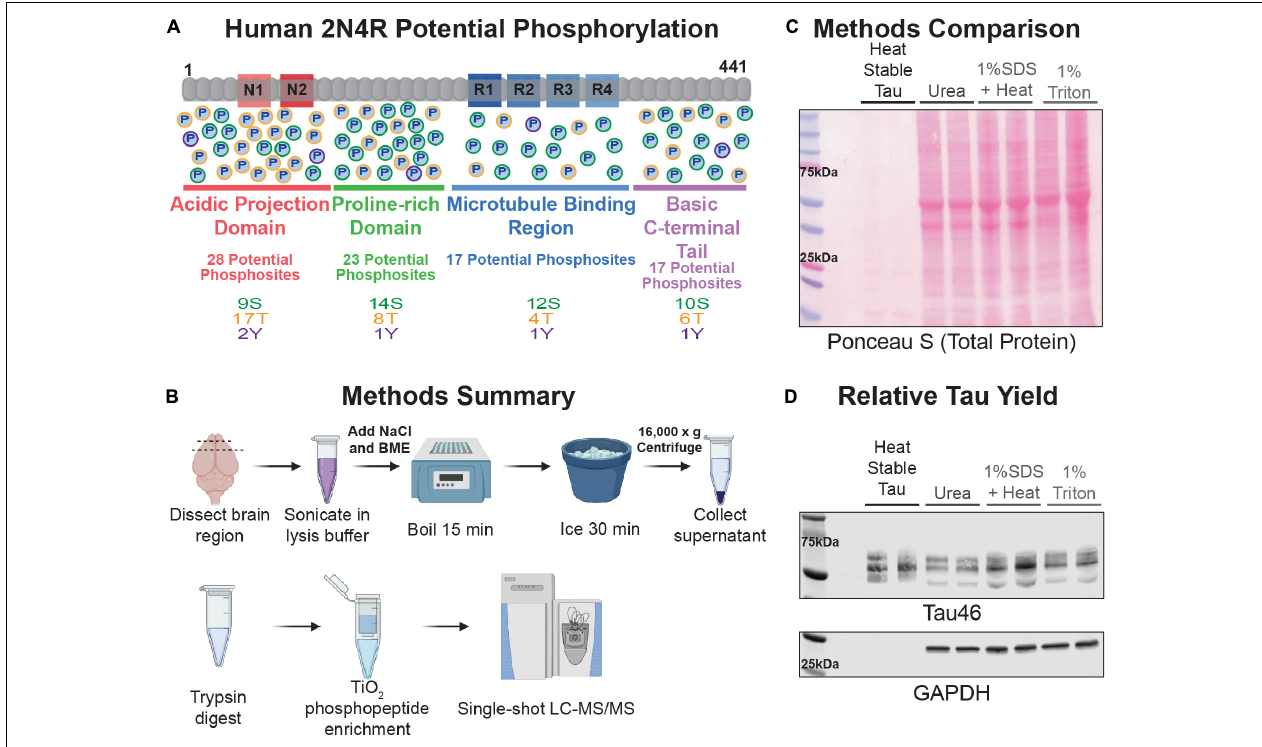
FIGURE 1 | Technique Overview. (A) Schematic representation of the longest isoform of human tau, 2N4R. The domains are represented and underlined with a length proportional to their amino acid number in the protein (acidic projection domain is red, proline-rich region is green, microtubule binding region is blue, and the basic C-terminal tail is lavender). Potential phosphorylation sites are represented by circles with a “P” in the middle in each domain and are color coded by residue type (serine outlined in green, threonine in orange, tyrosine in purple). (B) Cartoon summary of the heat-stable tau enrichment technique and mass spectrometry work-flow described in this study. (C) Samples were separated by SDS-PAGE and proteins transferred to nitrocellulose. Image of the ponceau S-stained nitrocellulose membrane of various rat FC lysates. Lysate prepared from two independent rat FC tissue samples were run side-by-side for each buffer type as labeled at the top of the image. An amount relative to starting mass was loaded for each sample. This was equivalent to 4 µ L for the heat-stable tau, urea, and 1% SDS + heat and 10 µ L for the 1% triton samples. (D) Immunoblot of the membrane shown in (C) blotted with antibodies against total tau (Tau46) and GAPDH.